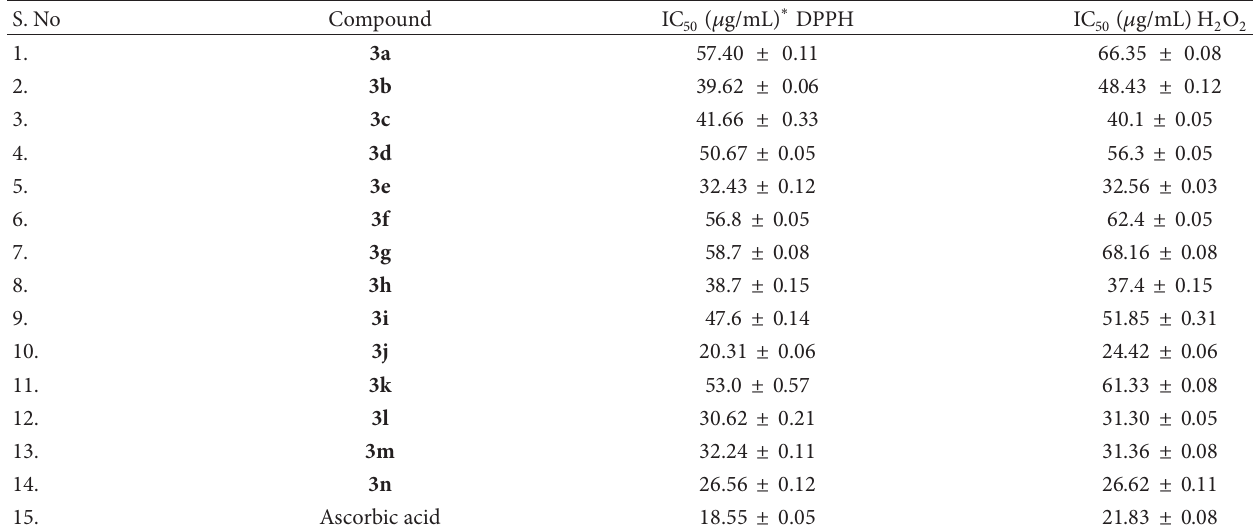
T 3: Antioxidant activity of synthesized